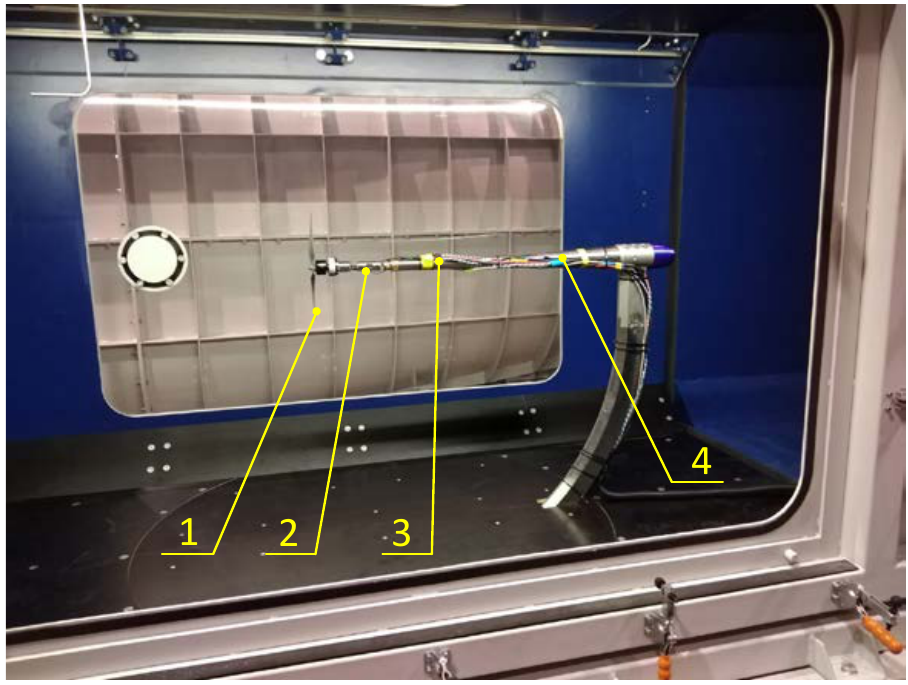
Figure 6. View of the wind tunnel test section with the research object: 1—tested engine-propeller unit, 2—force balance, 3—ESC, 4—sting.